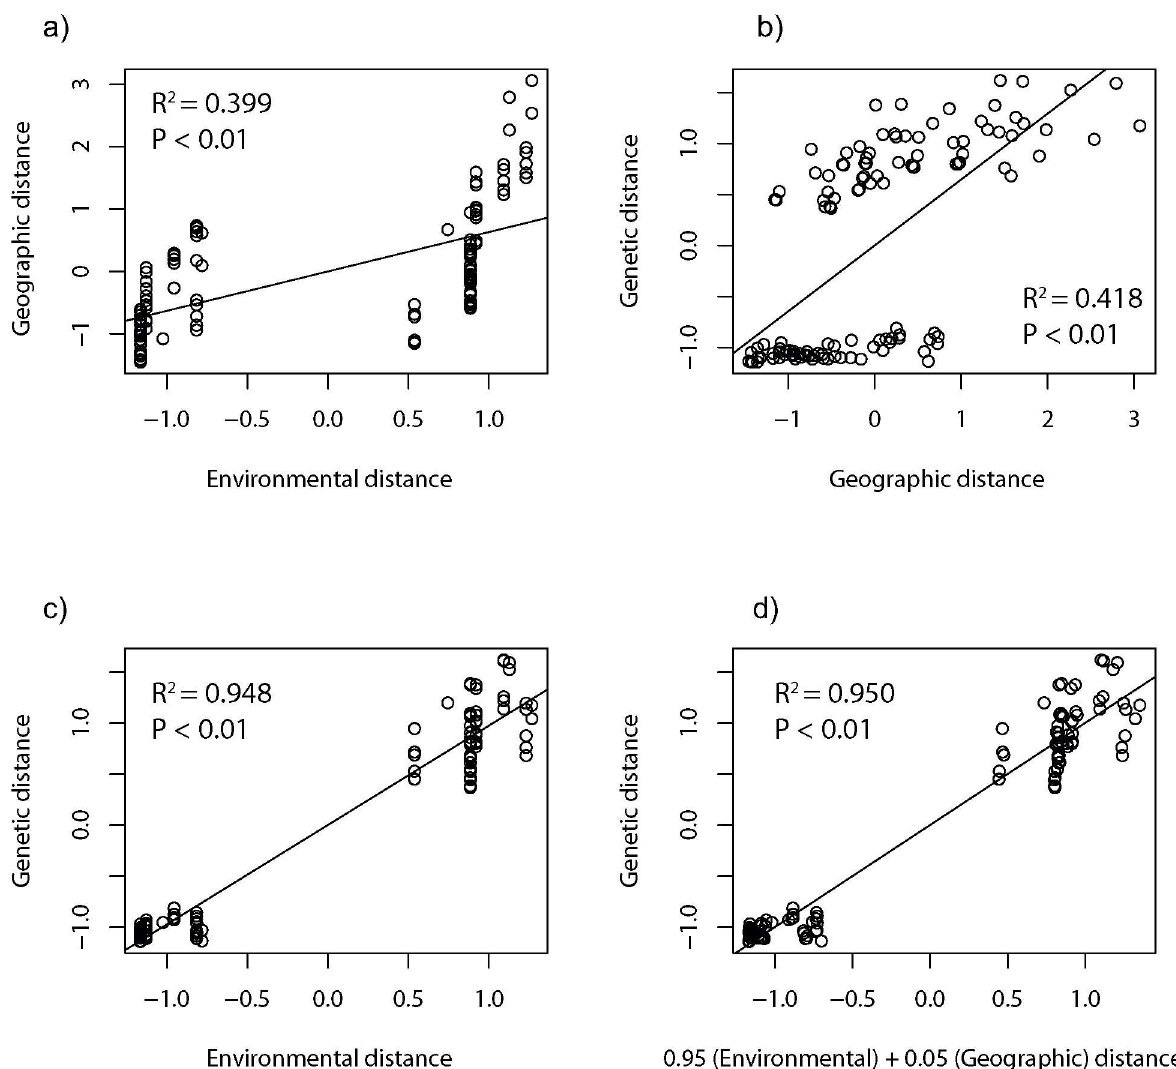
Fig 4. Results of multiplematrix regression withrandomization (MMRR)analysis. Plots show a) the relationship of environmental and geographical distance, b) isolation-by-distance(IBD),c) isolation-by-environment (IBE),and d) multipleregressionfor the effects of geographical (ß Distance = 0.05)and environmental (ß Environment = 0.95)distanceson